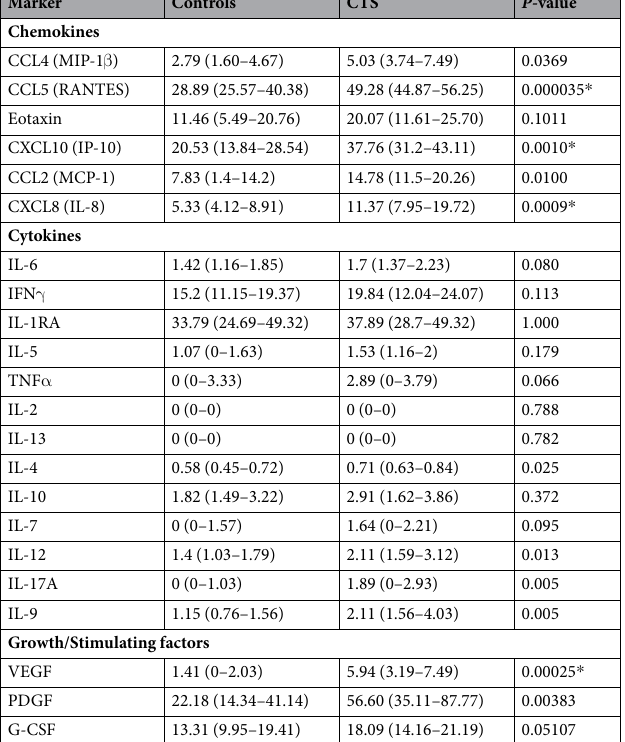
Table 4. Serum chemokines, cytokines, and growth/stimulating factors. Data are presented as median (pg/ml) and 95% confidence interval. P -values calculated using Mann–Whitney U test. * Denotes significance following Bonferroni correction for multiple comparisons ( P <